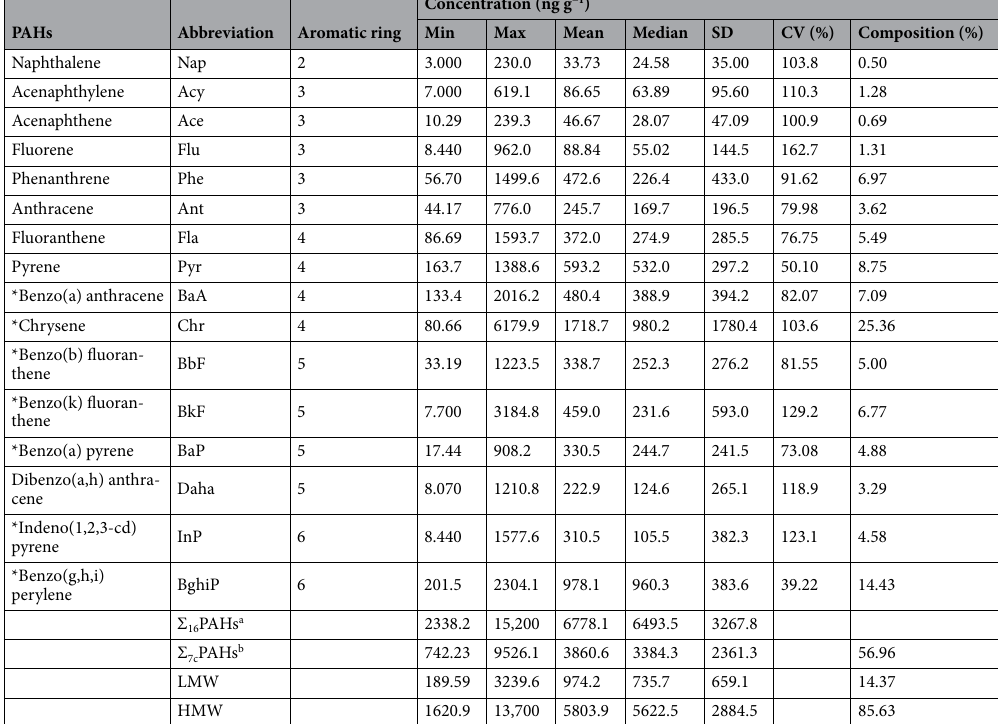
Table 1. Descriptive statistics of PAHs in soils of the studied region (ng g −1 , n = 51). SD standard deviation, CV coefficient of variation. a Σ 16 PAHs: total concentrations of 16 PAH. b Σ 7c PAHs: concentrations of 7 carcinogenic PAHs (BaA, Chr, BbF, BkF, BaP, InP,